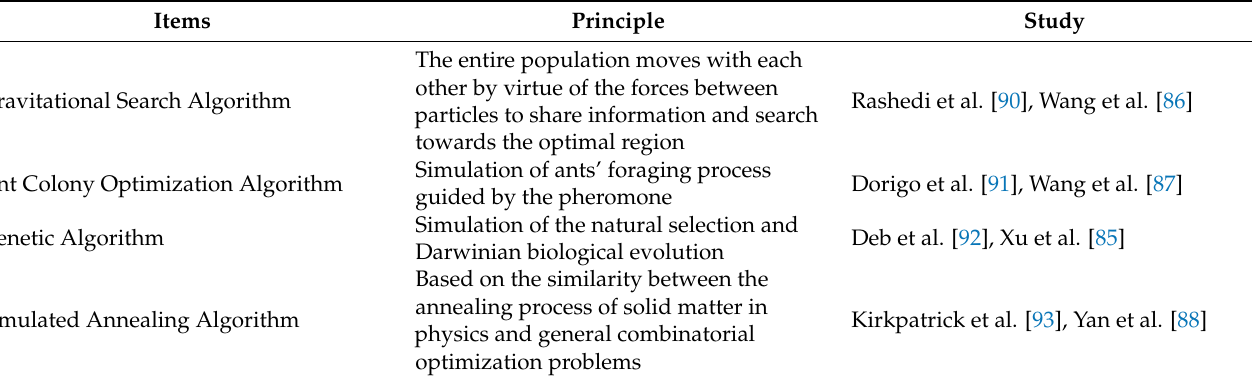
Table 3. UAV algorithm application